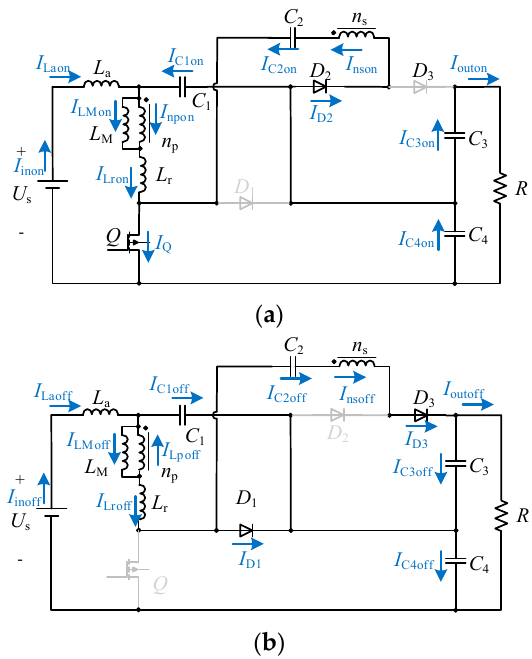
Figure 4. The current distribution in different states: ( a ) Q is turned on; ( b ) Q is turned off.